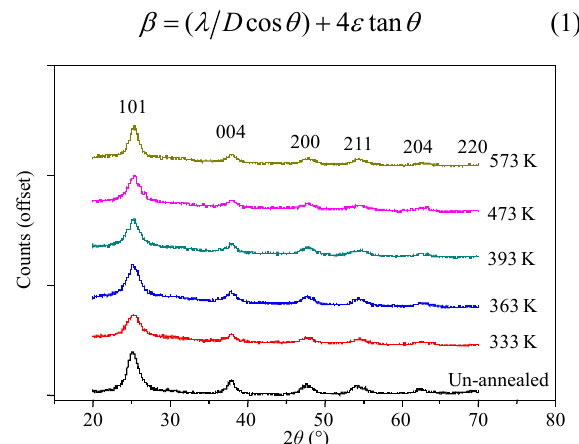
Fig. 1 XRD patterns of an un-annealed and 333 K, 363 K, 393 K, 473 K, and 573 K annealed